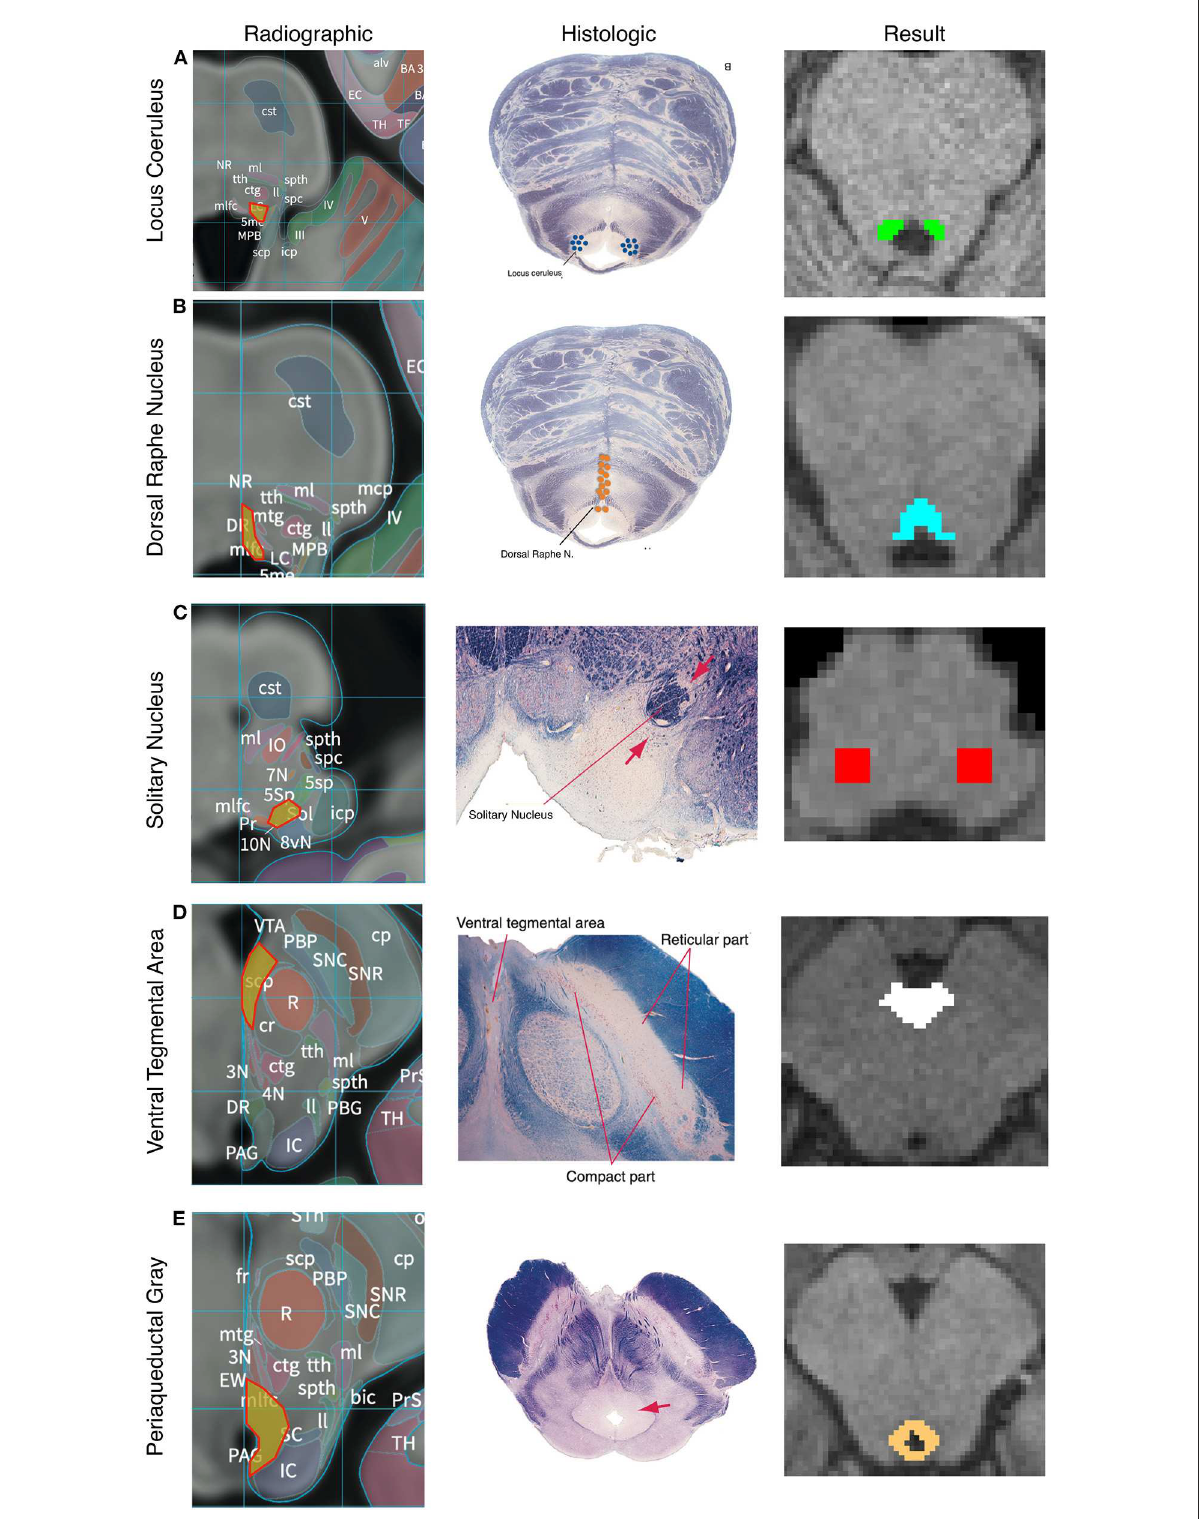
FIGURE2 Anatomic boundaries. Diagram of how anatomic boundaries of nuclei were masked. First radiographic 23 (left pane) and histologic atlas 24 (middle pane) were carefully examined for each nucleus. Using a combination of anatomic landmarks and voxel measurements (not shown), the resulting mask (right pane) was created in FSL. Locus Coreleus (A) , Dorsal Raphe Nucleus (B) , Solitary nucleus (C) , Ventral tenemental area (D) , Periaquaductal Grey (E)